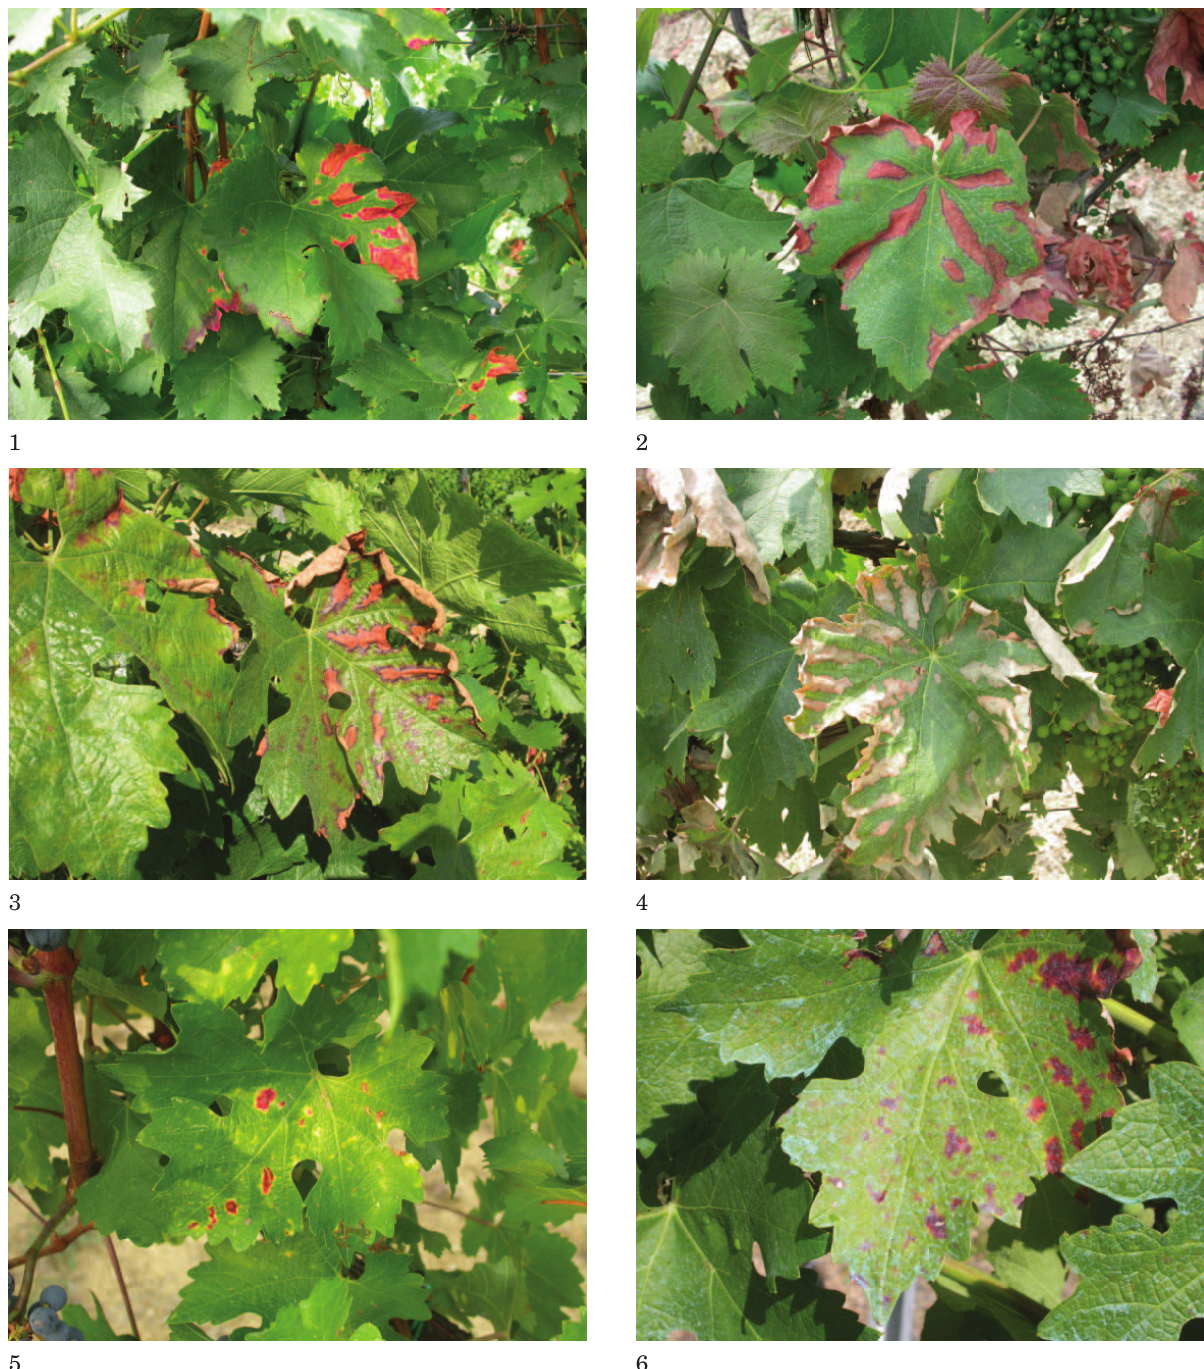
Fig. 1. Examples of symptom variability in the leaves of grapevine plants that have been classified as esca diseased for many years (average vine age: 25 years). 1–14, symptoms at the initial stage of development. 15–30, foliar symptoms at the final stage of esca, before leaf fall. Some of the symptoms may be typical of diseases other than esca. For example, leaf 25 exhibit a red or purplish color, a symptom that recalls leaf- roll virus disease. (However, with this latter disease the symptom is usually accompanied by a